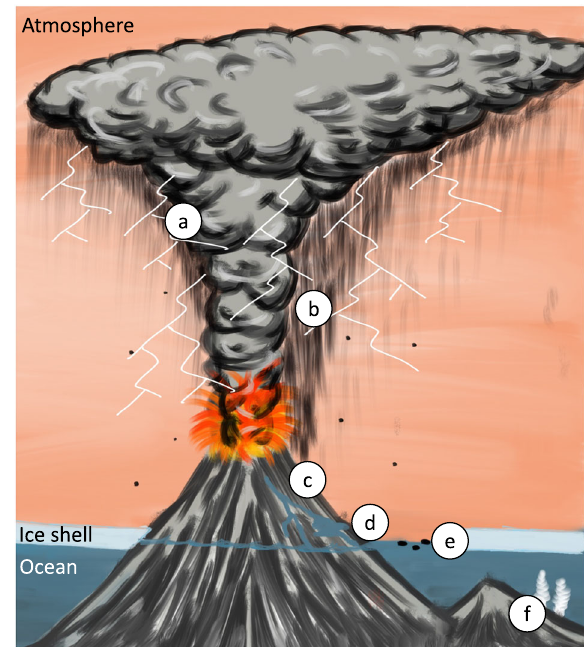
Fig.1|SchematicofthehypothesizedHadeanvolcanicislandsetting,erupting through the ice, generating lightning and subsequent prebiotic chemistry. a Volcanic lightning generates prebiotic reagents; b Condensation and rain out of organic products; c Run off, concentration in ponds, warm/dry cycles encourage reactions; d Tidal action where ice shell is discontinuous, washing into the sub-ice ocean; e pumice rafts transporting adsorbed reagents; f Further processing in hydrothermal setting forming more complex organic compounds. Image credit Samuel